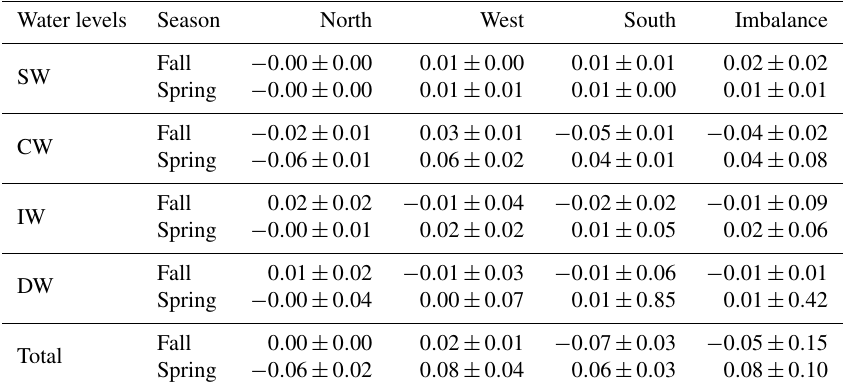
Table 7. PO 4 transports and their errors (kmols − 1 ) for CW, IW and DW for the north, west and south transects. Positive–negative values indicate outward–inward transports. The last row is the integrated transport in the entire water column in each transect, and the last column represents the net transport of this variable inside the